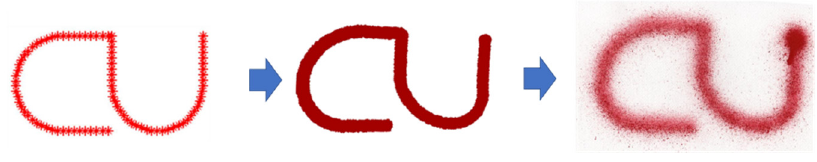
Figure 8. Designed Scenario of the Collaborative Painting Robot .